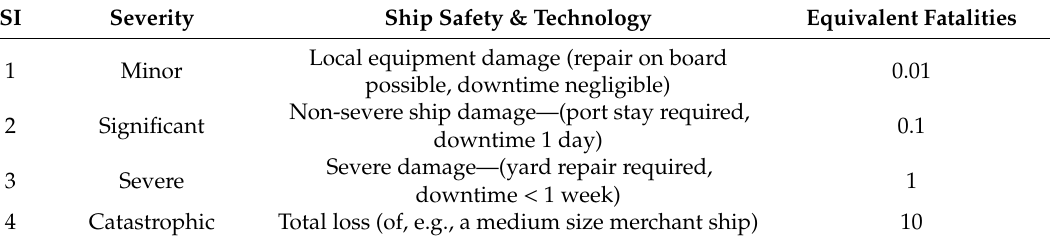
Table 2. Definition of consequence index [21].